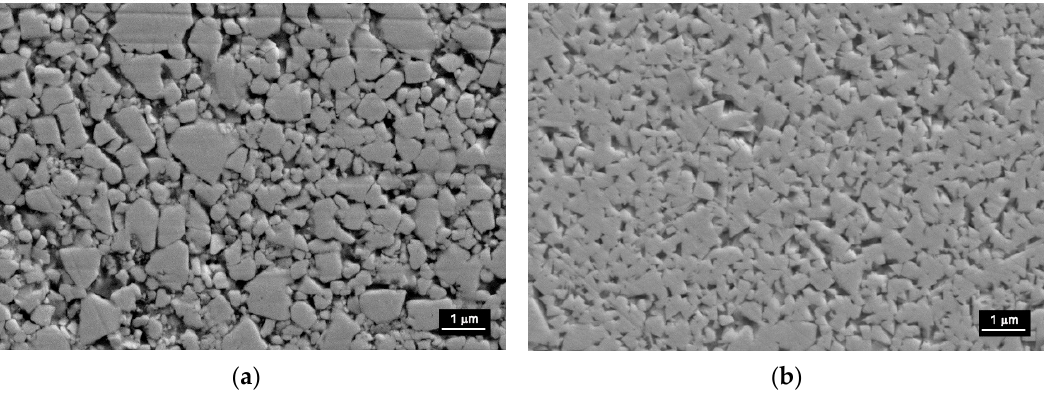
Figure 10. SEM images of ( a ) polished HVAF and ( b ) 12CoUF samples after electrochemical tests.